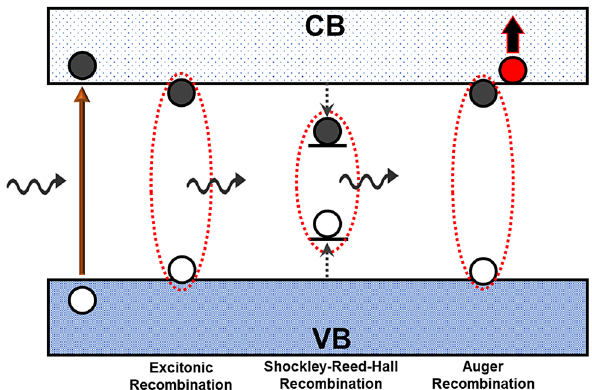
Figure 2: Different carrier recombination mechanisms in semiconductors, including monomolecular recombination such as excitonic recombination (radiative) and Auger (trimolecular) recombination (nonradiative). Trap-assisted recombination (e.g. Shockley-Read-Hall) can result in both radiative and nonradiative recombination.